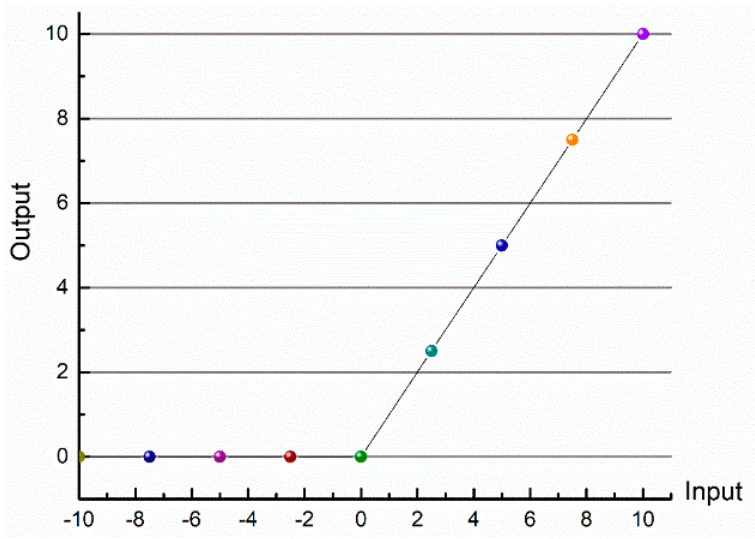
Figure 5. Rectified linear unit (ReLU) function.